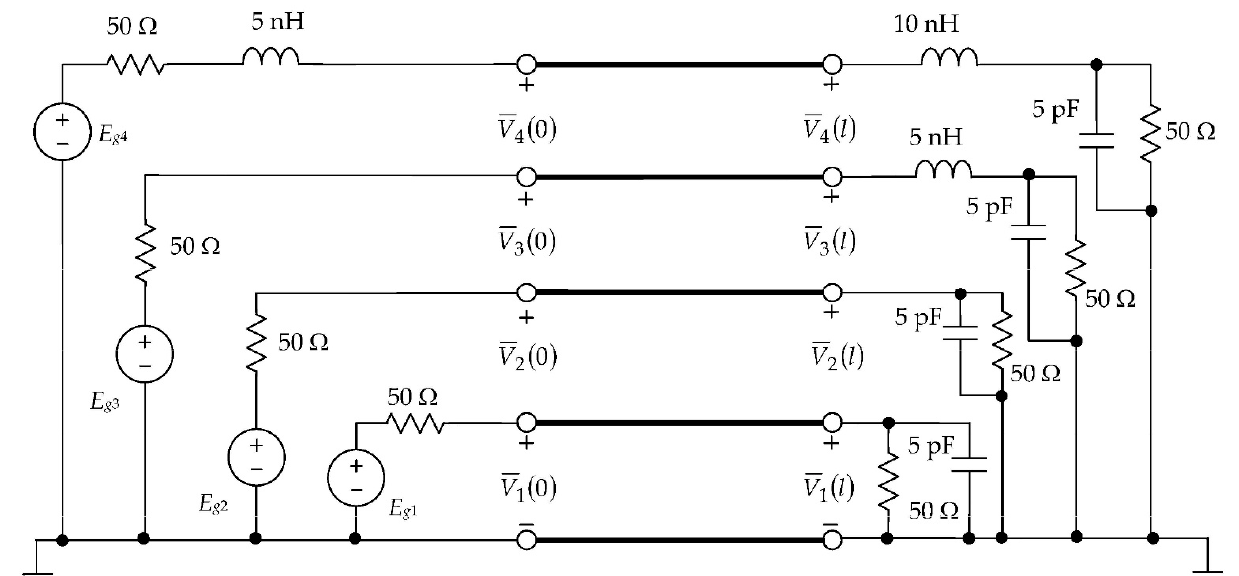
Figure 5. Circuit including five-conductor transmission line.